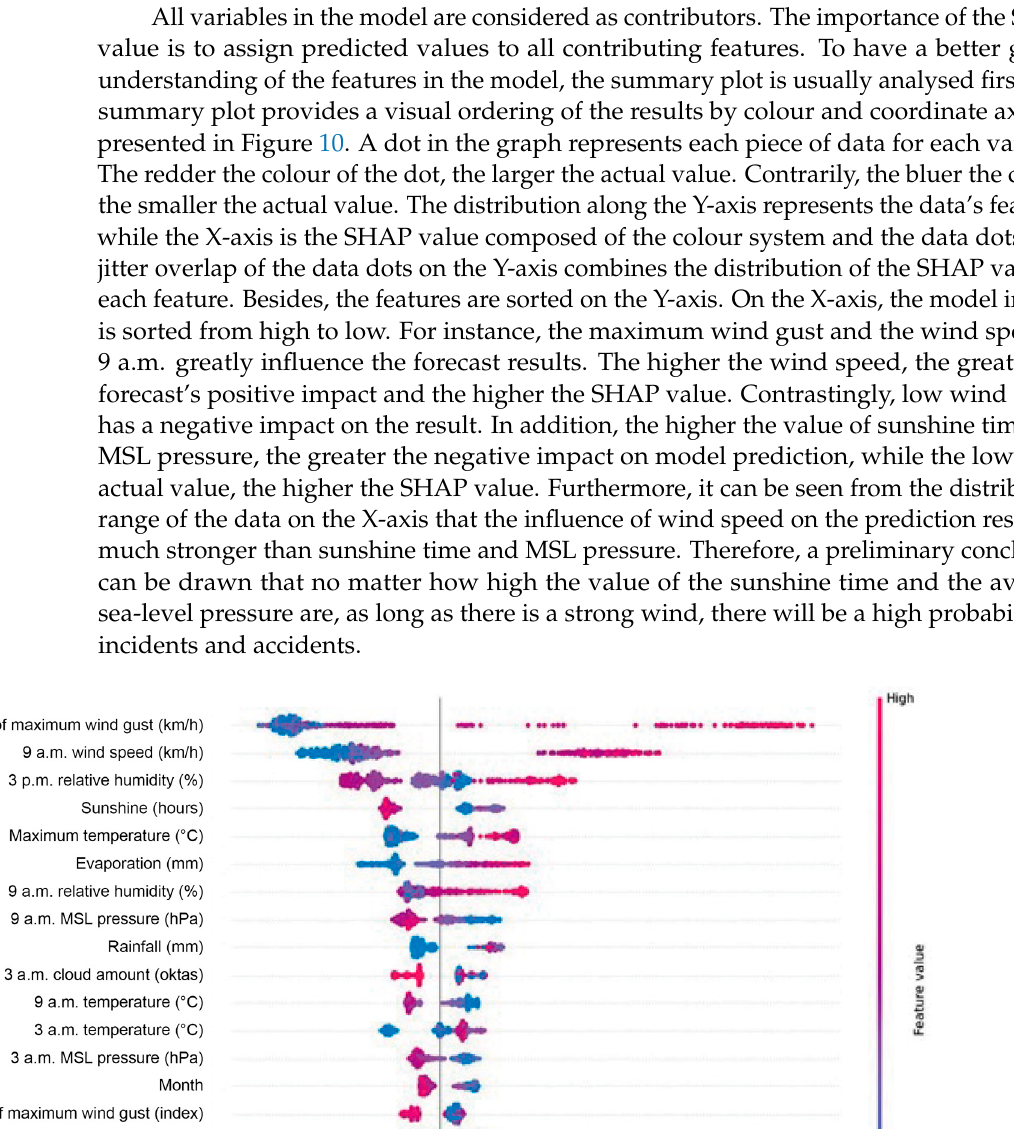
Figure 11. SHAP explanation of dependence plot for speed of max wind gust.